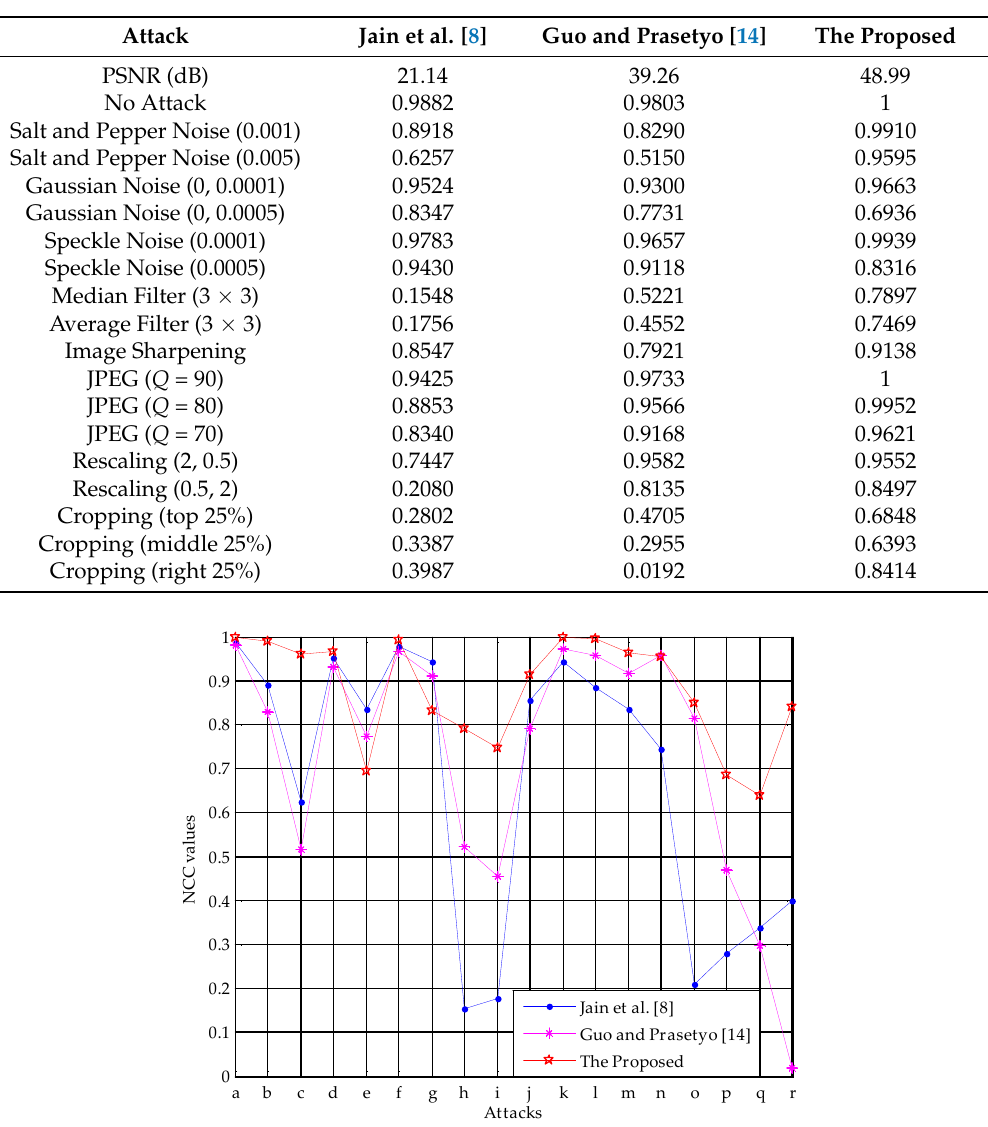
Table 4. NCC values of the extracted watermarks in image Barbara under different attacks.